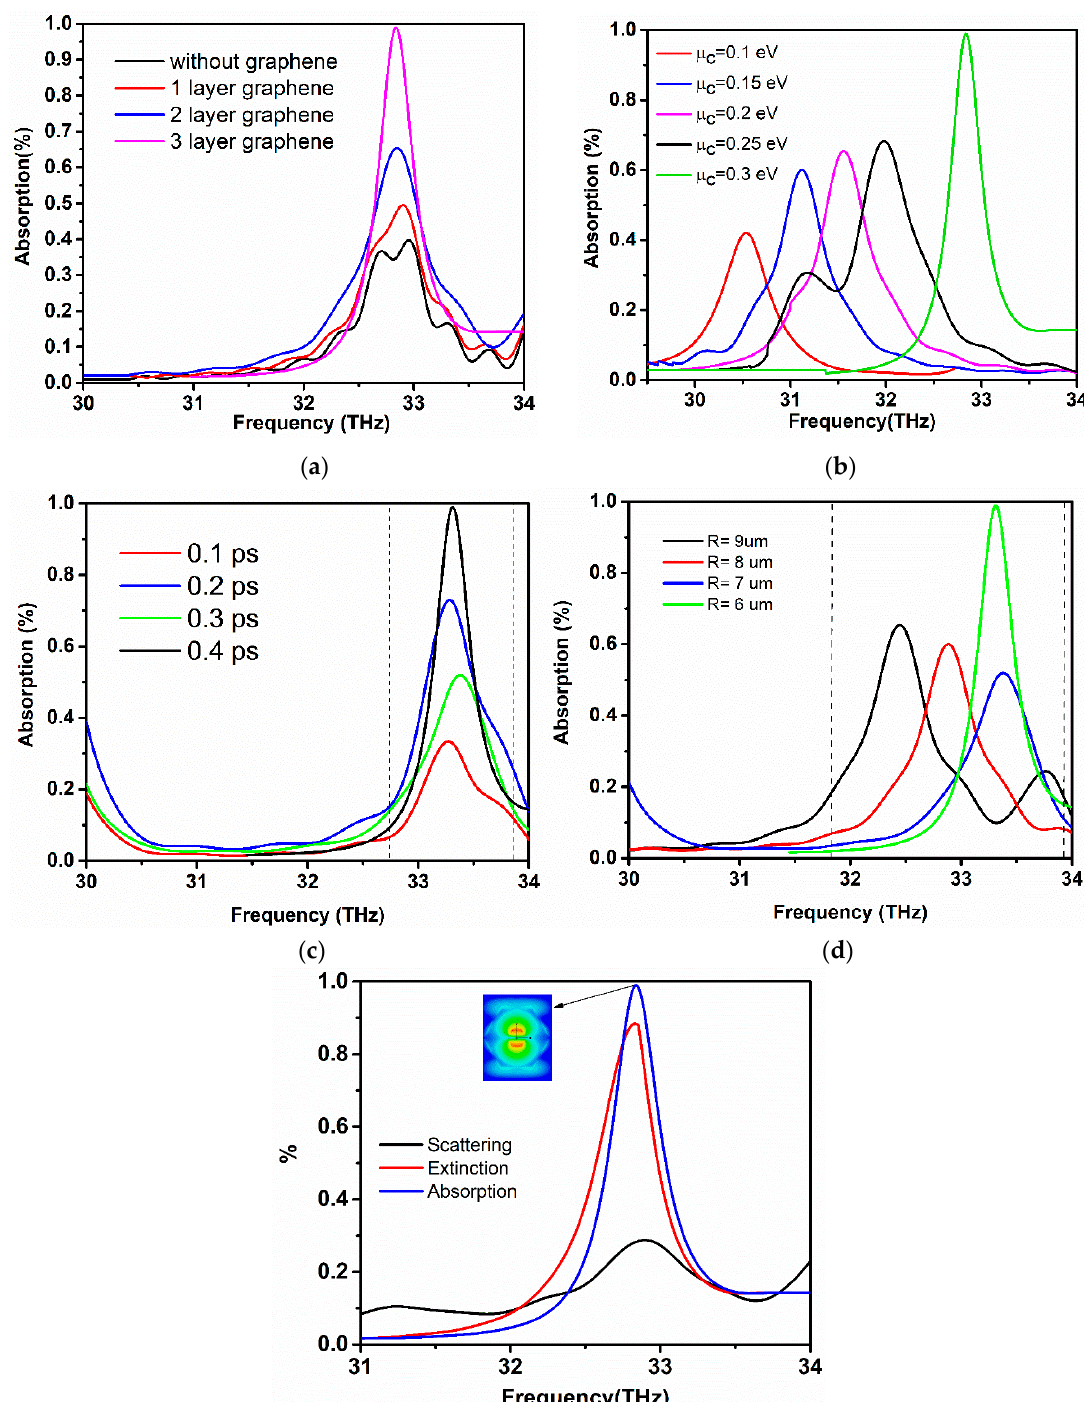
Figure 14. ( a ) Absorption spectra with graphene layers, ( b ) Absorption spectra tuning with chemical potential, ( c ) Effect of relaxation time on absorption, ( d ) Tuning of absorption spectra by increasing hexagon size, and, ( e ) Comparison of the simulated absorption, Scattering and extinction of the antenna at the resonance frequency, i.e., 33 THz with the graphene Fermi energy tuned to 0.3 eV. The black line represents the scattering magnitude, which is far lower than the absorption magnitude, thus validating the proposed structure has the ability to absorbs the maximum portion of the incident light.